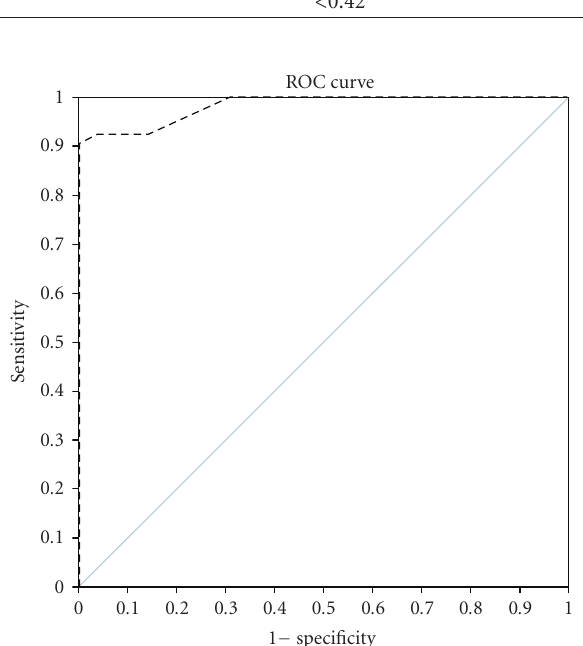
cases (68.1%), with smooth defined margin in 70 cases (97.2%), with no surrounding echogenicity to all 72 cases (100%), with hyperechoic echotextures in 63 cases (87.5%), and with homogenous echotextures in 37 cases (51.4%). Acoustic transmission was present in 36 cases (50%) and compression pattern was observed in 69 cases (95.8%). Malignant tumors, on the contrary, appeared in 3D with chaotic vessel architecture with complex branching pattern (Figure 4) in 28 cases (52.8%). The R.I. value was lower than 0.42 in 2 cases of benign (2.8%) and in 24 cases of malignant tumors